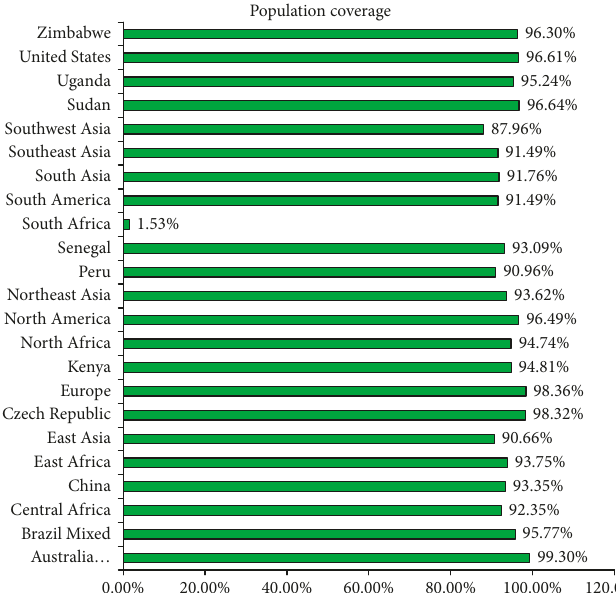
Figure 2: Population coverage of the epitopes and their respective HLA alleles of the OROV polyprotein. The epitopes with di ff erent HLA-binding speci fi cities increase the population coverage as the several HLA types are expressed at radically di ff erent frequencies in various